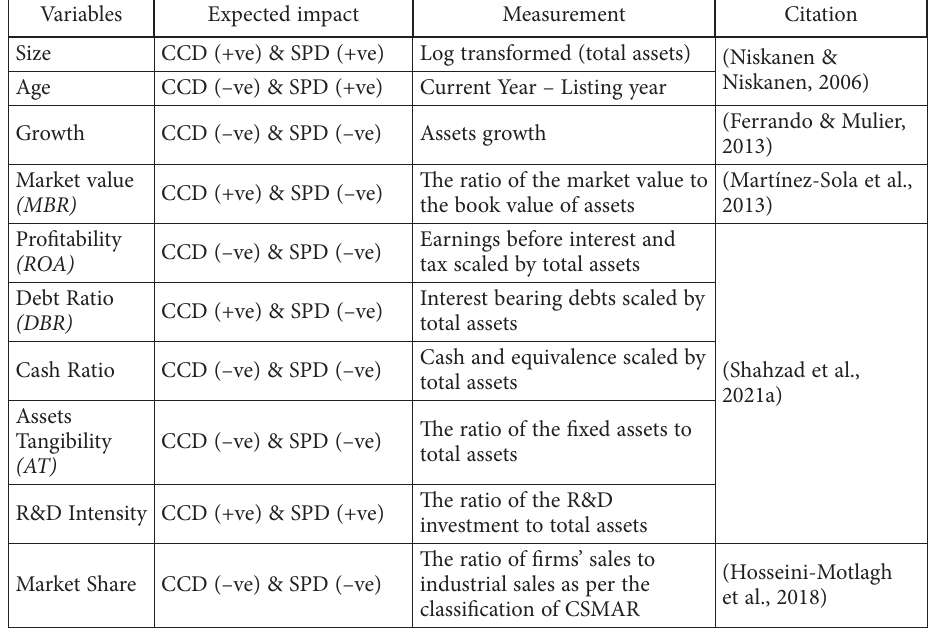
Table 2. Description of control